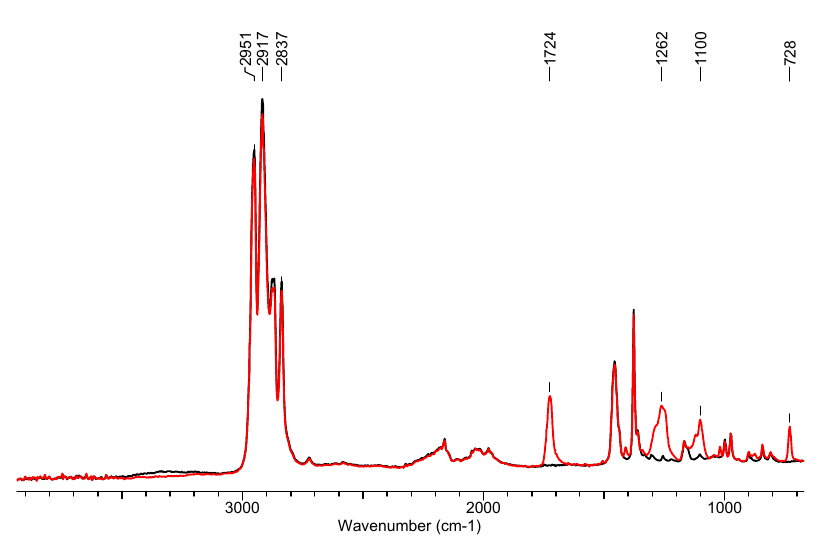
Figure 7. FTIR spectrum of nonwoven based on polypropylene WP 0 (1—black line) and nonwoven WSB 0 (2—red line).